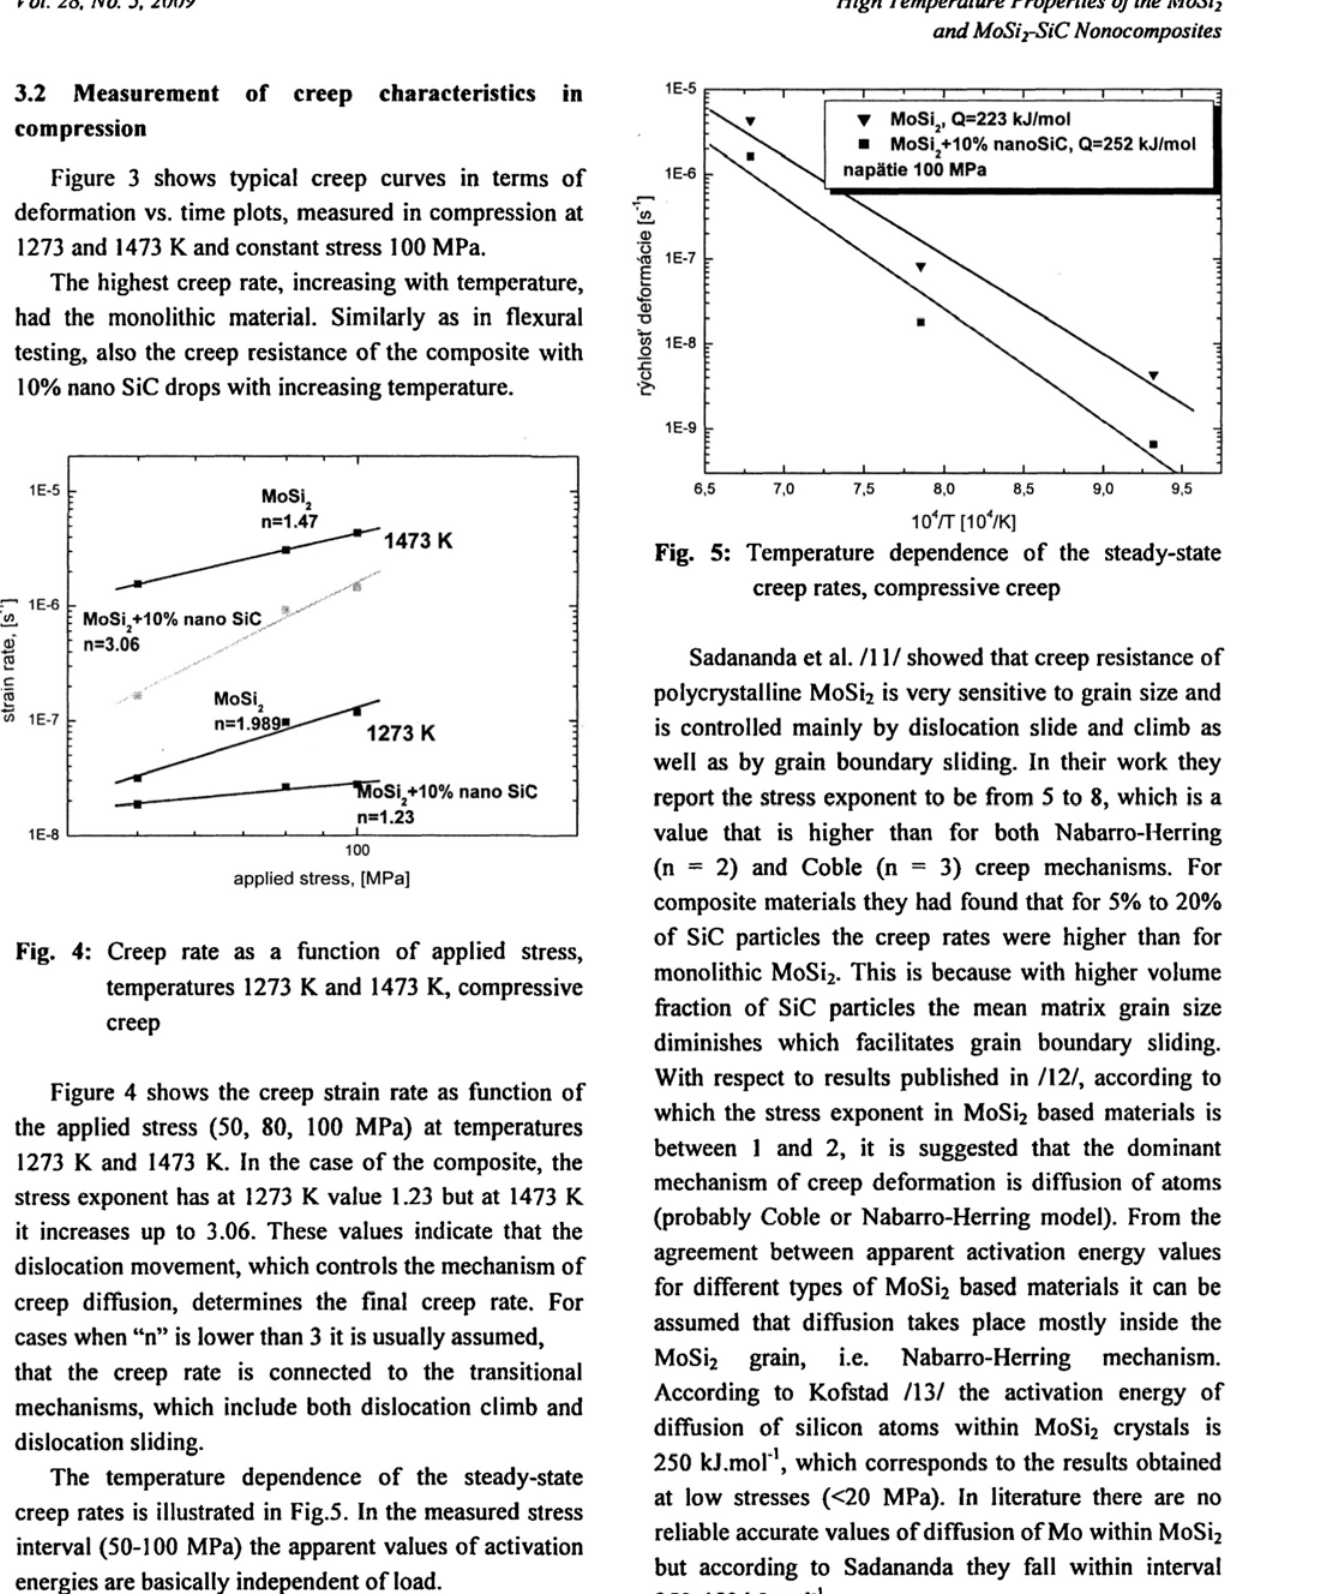
Fig. 4: Creep rate as a function of applied stress, temperatures 1273 Κ and 1473 K, compressive creep